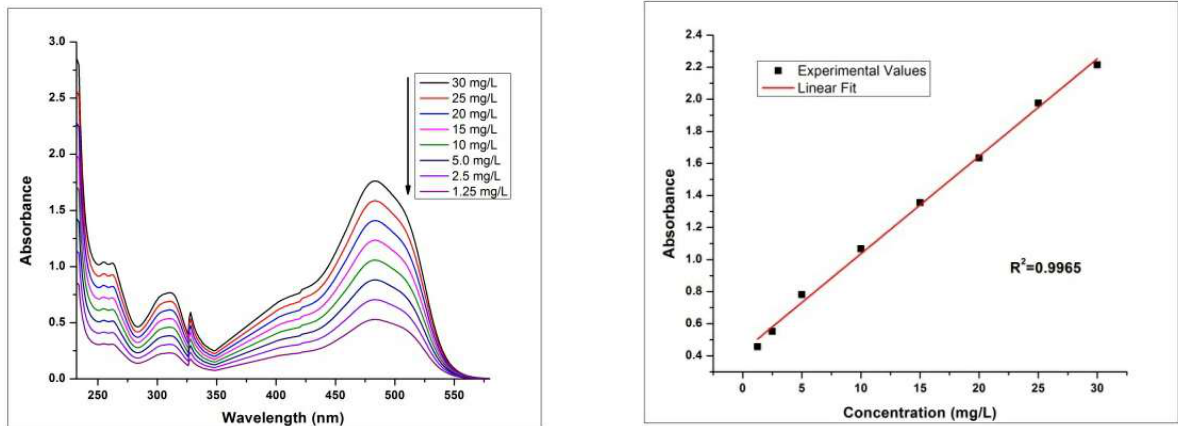
Figure 17. UV-Vis plot of standard aqueous solutions of MO for different concentrations ( left ) and